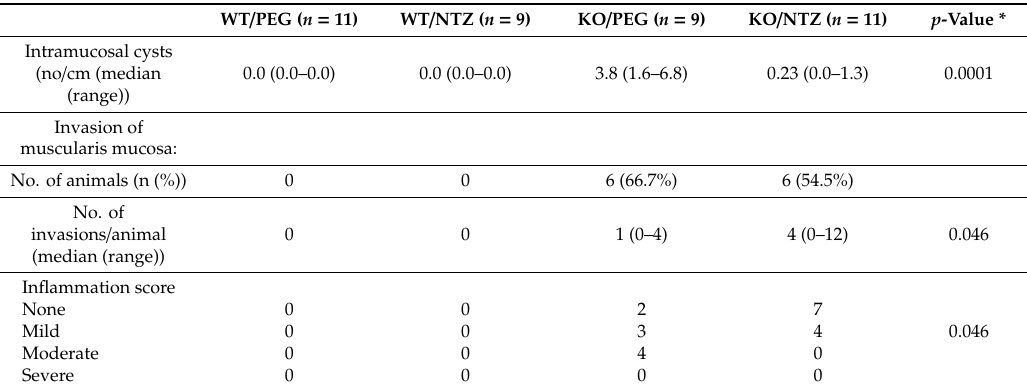
Figure 2. Hematoxylin and eosin stained sections of the oxyntic mucosae from WT/PEG mice ( A ), KO/NTZ mice ( B ) and KO/PEG mice ( C ). There is marked hyperplasia and intramucosal cysts in KO mice that are reduced by NTZ. Scare Bar = 100 µm. Table 1. Quantification of histopathological changes. Histopathological changes of the gastric corpus mucosa in KO mice given PEG (KO/PEG) or NTZ (KO/NTZ) and WT controls given PEG (WT/PEG) or NTZ (WT/NTZ).